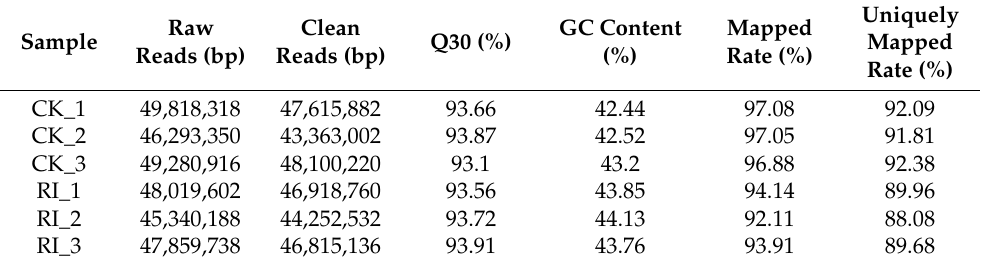
Table 1. Statistics and quality testing of transcriptome sequencing data.